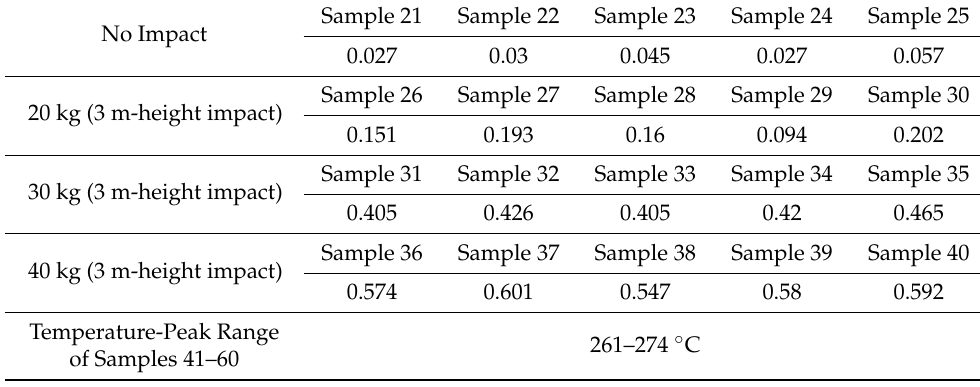
Table 7. The normalized shock-damage data of concrete samples after burning (foot of the arch).